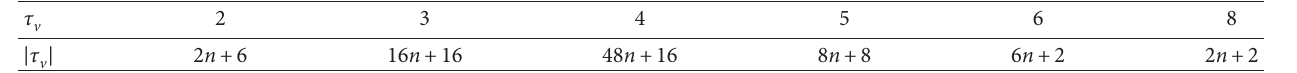
Table 6: Partitions of K ’s vertices according to the connection number.